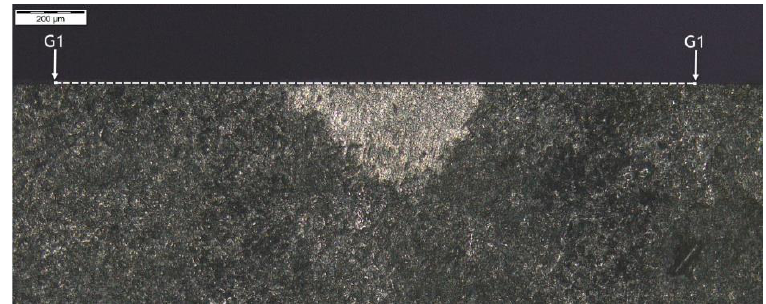
Figure 15. Localization of cross-section G1-G1, zone: 3C.